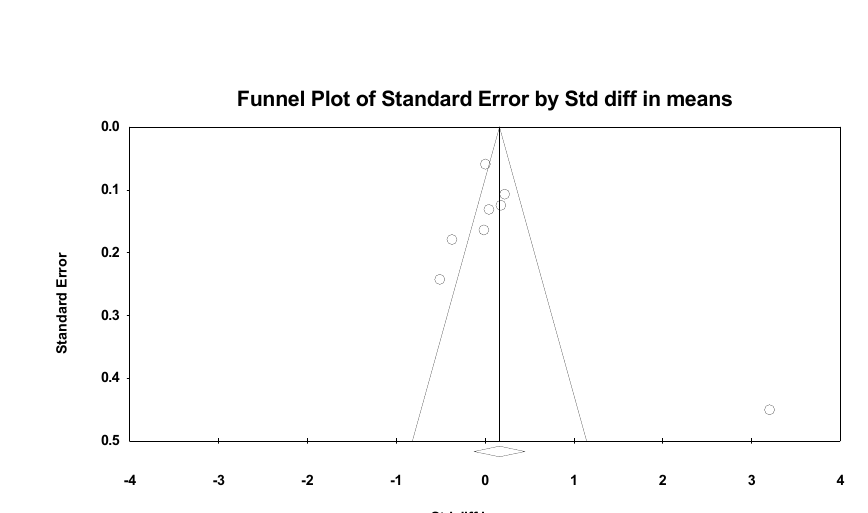
Figure 3. Meta-analysis of BPA exposure by childhood obesity. ( A ) Forest plot of eight studies on the Figure 3. Meta ‐ analysis of BPA exposure by childhood obesity. ( A ) Forest plot of eight exposed BPA concentration by childhood obesity. ( B ) Forest plot of six studies, except two pilot studies, studies on the exposed BPA concentration by childhood obesity. ( B ) Forest plot of six on the exposed BPA concentration by childhood obesity. ( C ) Funnel study in the meta-analysis on the association between BPA exposure and childhood